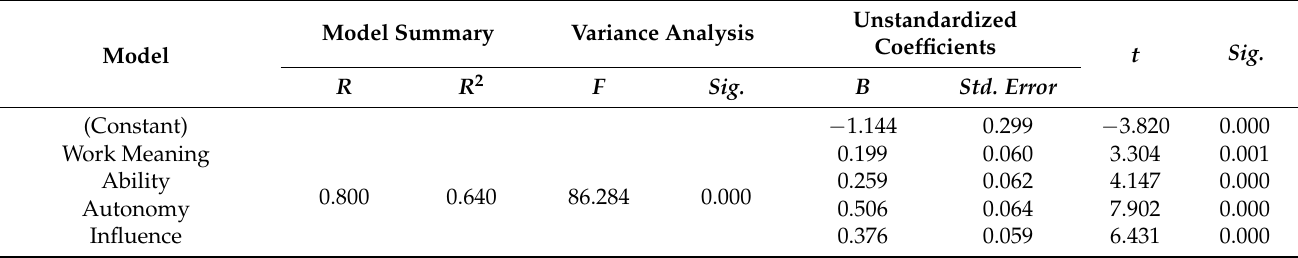
Table 19. Regression Analysis of Psychological Empowerment on Employee Task